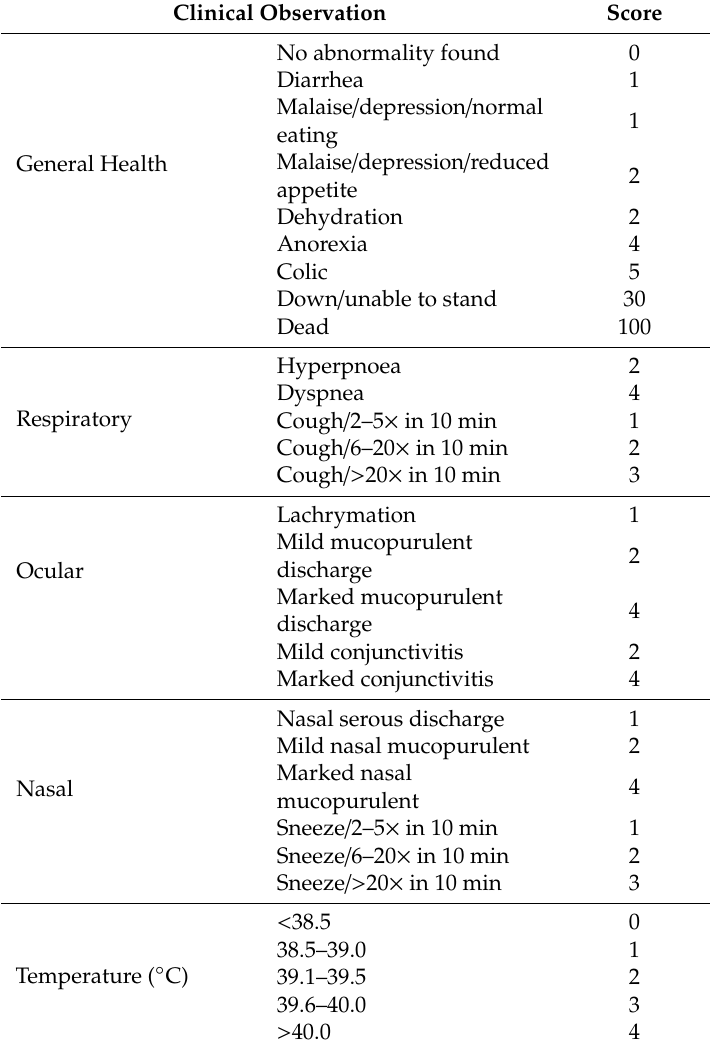
Table 1. Scoring system for observation of clinical